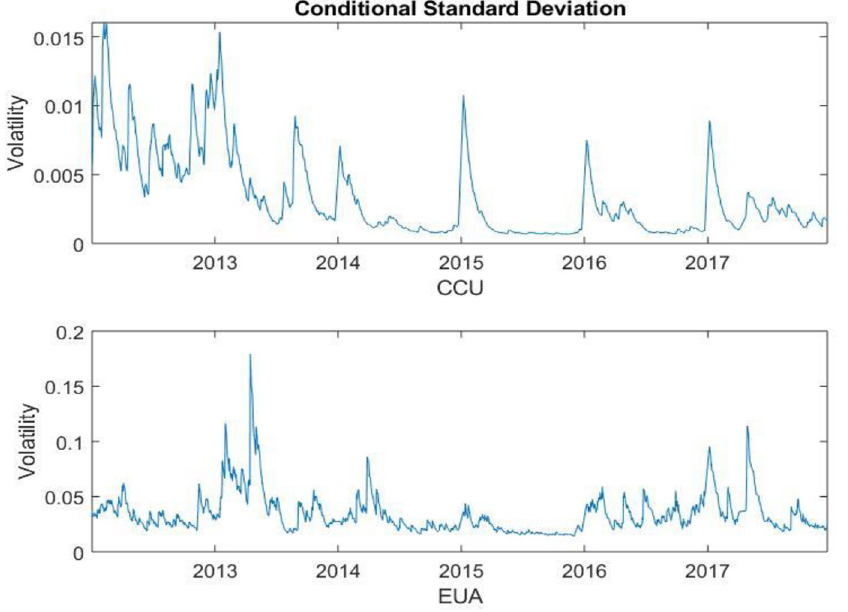
Fig 2. The conditional standard deviation time series using GARCH(1,1) filtering process.